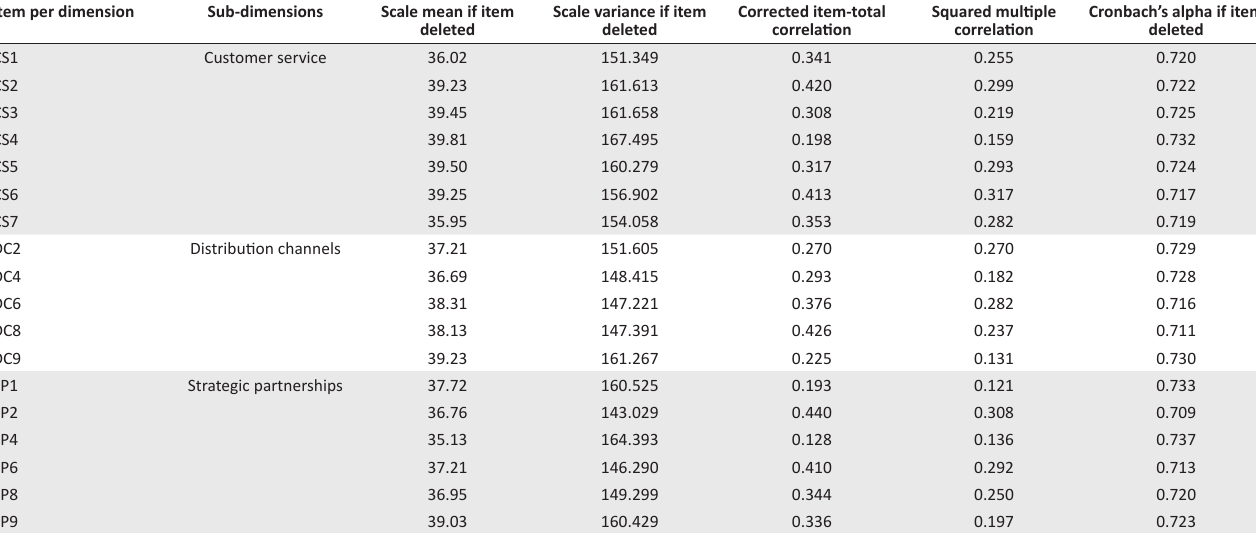
TABLE 13: Iterative item reliability analysis: Relational capital disclosure. Item per